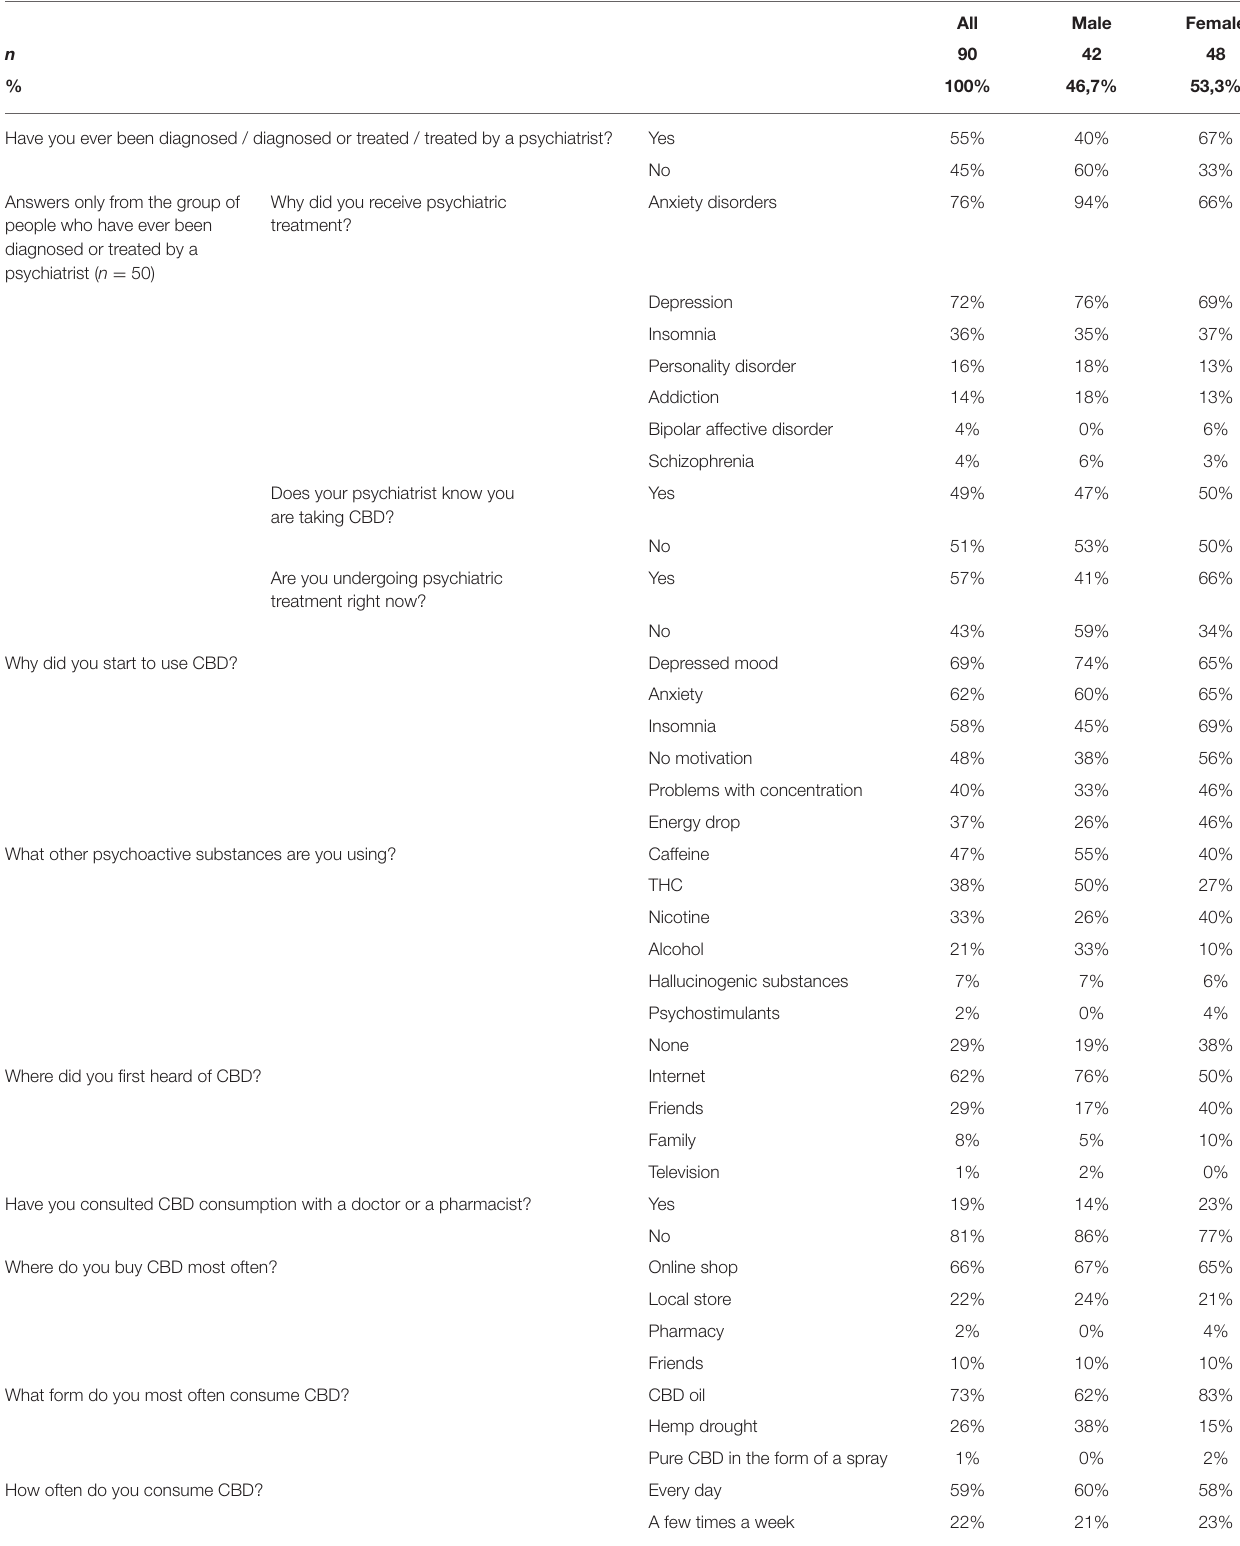
TABLE 2 | CBD consumption characteristics.